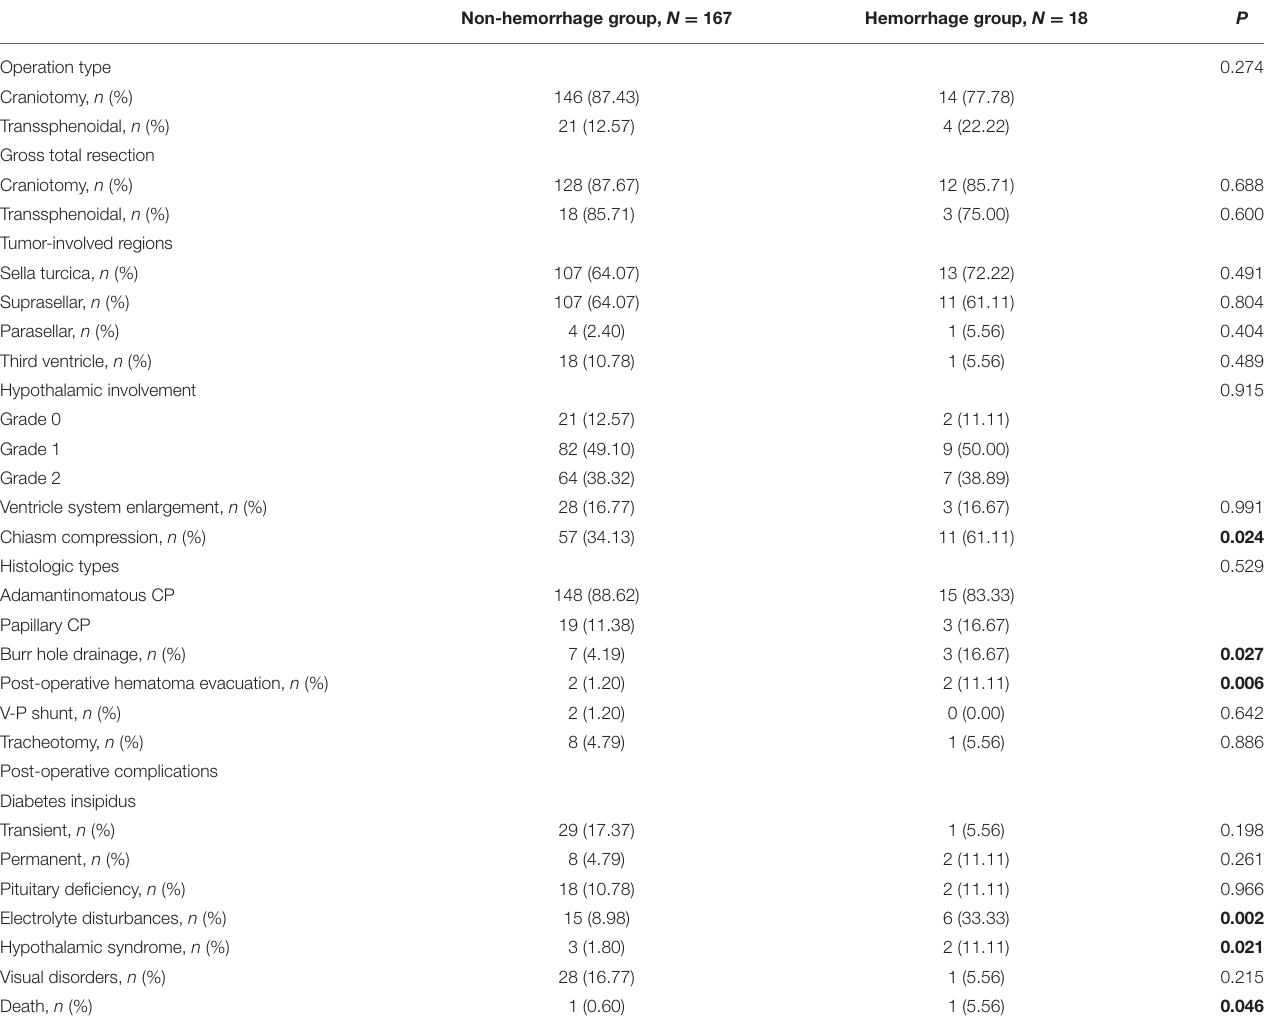
TABLE 2 | Surgery, radiographic and histologic characteristics, and post-operative complications in CP patients. Non-hemorrhage group, N = 167 Hemorrhage group, N =